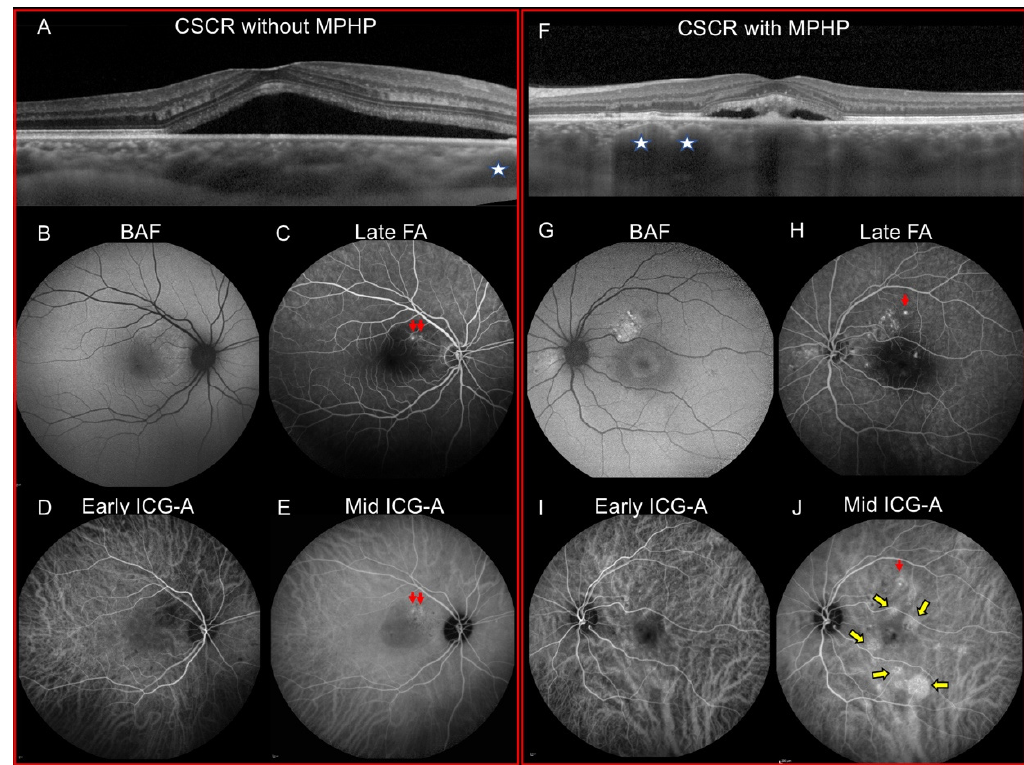
Figure 1. Multimodal imaging of patients with central serous chorioretinopathy (CSCR) without mid-phase hyperfluorescent plaques (MPHP) ( A – E ) and with MPHP ( F – J ). ( A – E ) A 35-year-old man with CSCR in the right eye. ( A ). The horizontal enhanced depth imaging (EDI) OCT centered on the fovea shows a macular serous retinal detachment (SRD). A dilated choroidal vessel is visualized (stars). ( B ). Blue-light fundus autofluorescence shows a mixed hyper- and hypo-autofluorescent area at the SRD. ( C ). Late-phase fluorescein angiography (FA) shows two focal leaks (arrows). ( D ). Early-phase indocyanine green angiography (ICG-A) is unremarkable. ( E ). Mid-phase ICG-A shows the two focal leaks (arrows) visualized on FA without MPHP. ( F – J ) A 46-year-old man with CSCR in the left eye. ( F ). An EDI-OCT centered on the fovea shows a macular SRD associated with dilated choroidal vessels (stars). ( G ). Blue-light fundus autofluorescence shows a superior hyper-autofluorescent area consistent with a previous SRD. ( H ). Late-phase FA shows a leaking point (red arrow) and an ill-defined hyperfluorescent area consistent with retinal pigment epithelium changes. ( I ). Early-phase ICG-A shows inferior dilated choroidal veins. ( J ). Mid-phase ICG-A shows multifocal MPHP (yellow arrows). The focal leak seen on FA is also detected on mid-phase ICG-A (red arrow).